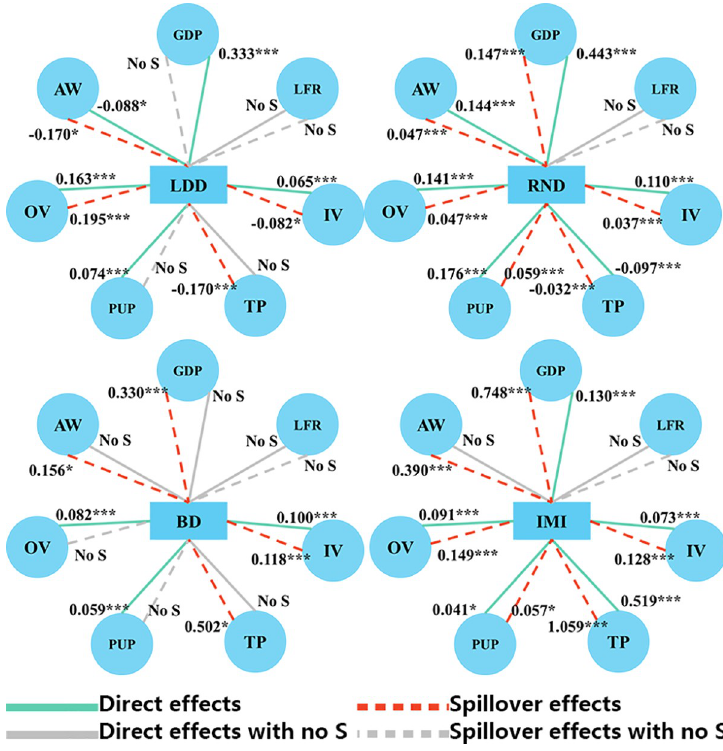
Fig 3. Summary of direct and spillover effects of variables on the different health